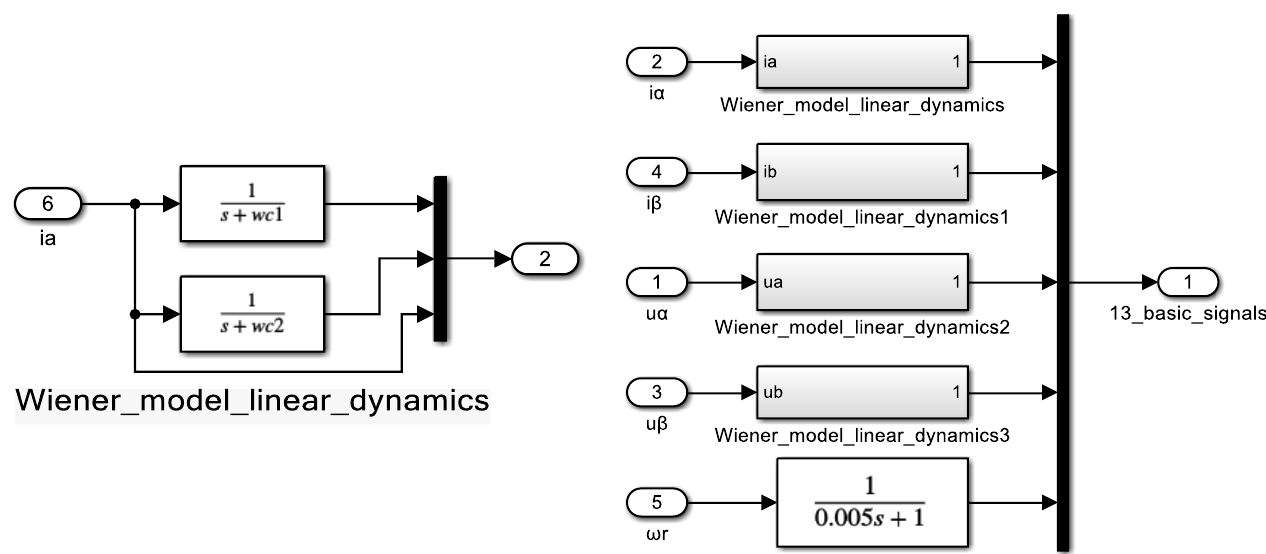
Figure 9. The feed-forward neural network of flux estimator.